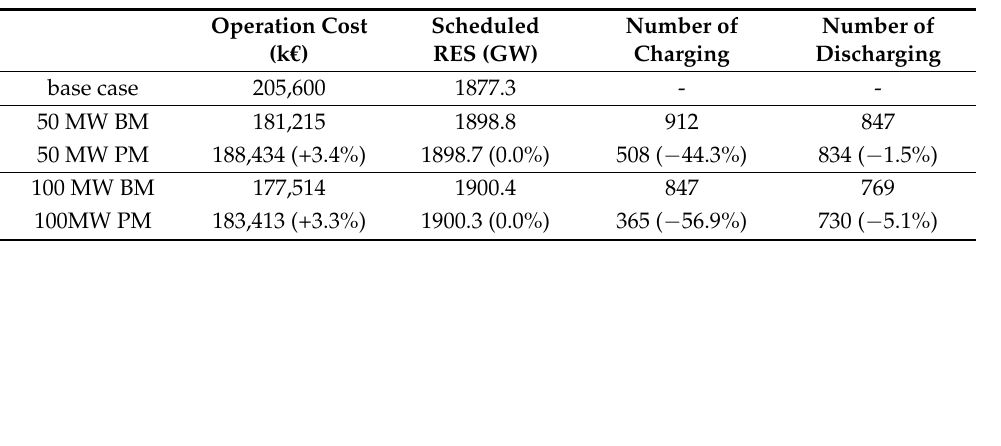
Table 2. Yearly Results of